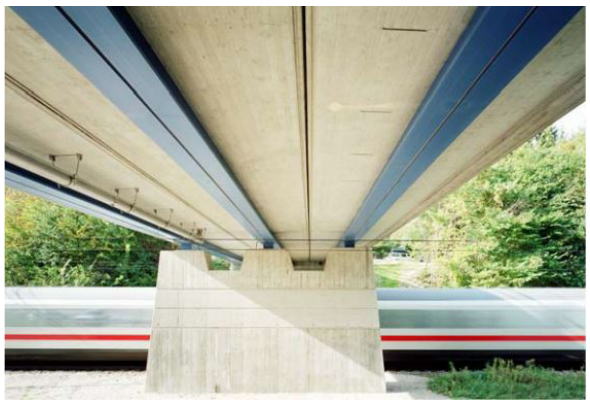
Figure 6: Composite girders of the viaduct in Pöcking [50] with puzzle-shaped dowels.